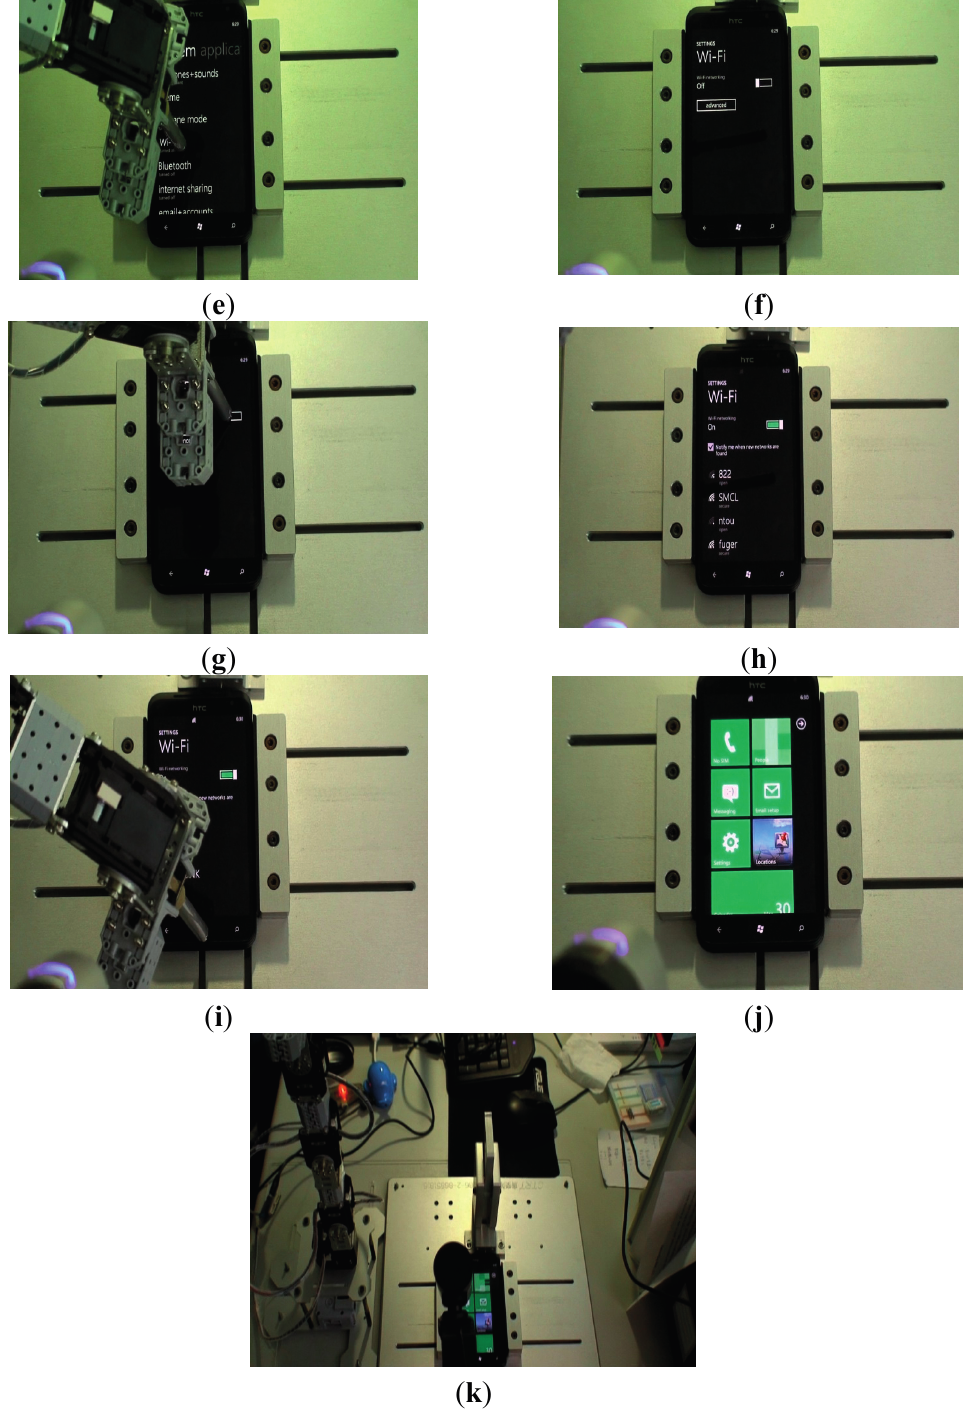
Figure 27. Command: Turn on WiFi. ( a ) Snapped words from command panel (PC screen); ( b ) Captured words recognized by processor; ( c ) Move robot arm to touch the setup icon; ( d ) Robot camera recognizes the WiFi location; ( e ) Move robot arm to touch the Wi-Fi; ( f ) Enter WiFi page; ( g ) Turn on WiFi switch; ( h ) Check WiFi is “on” by the robot camera; ( i ) Touch home page icon; ( j ) Return to home page; ( k ) Robot arm moves back to original